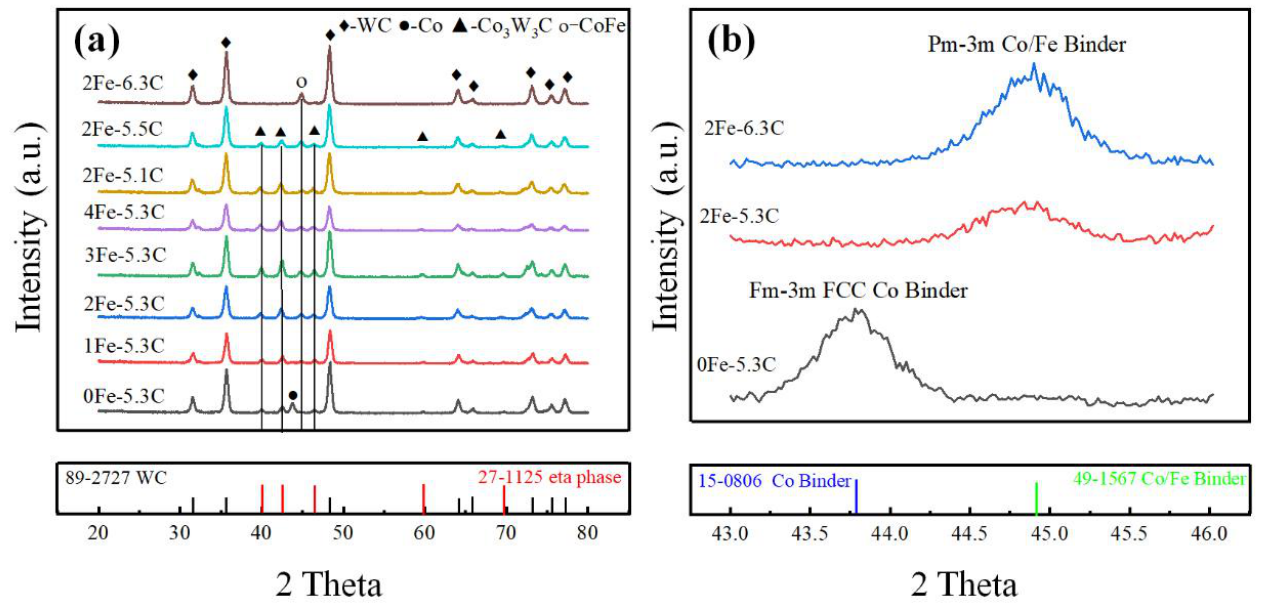
Figure 2. XRD patterns of WC–13 (Co–Fe) composites with different contents of Fe and C (a) and the enlarged XRD patterns between 43° and 46° (b).